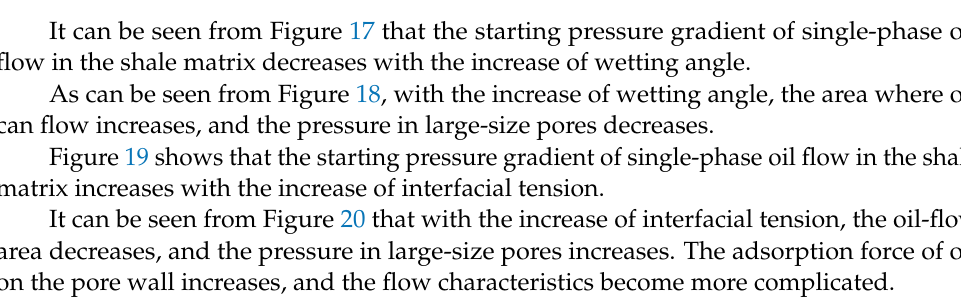
Figure 16. Simulation results of hydrophilic minerals with different proportions.